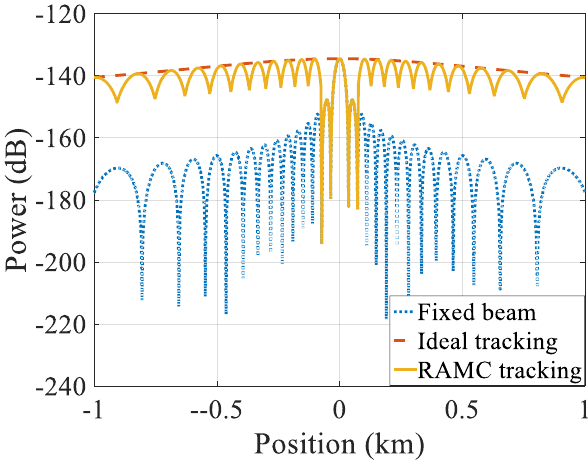
Figure 7. Comparisons of the received power of RAMC with ideal tracking and fixed beam.